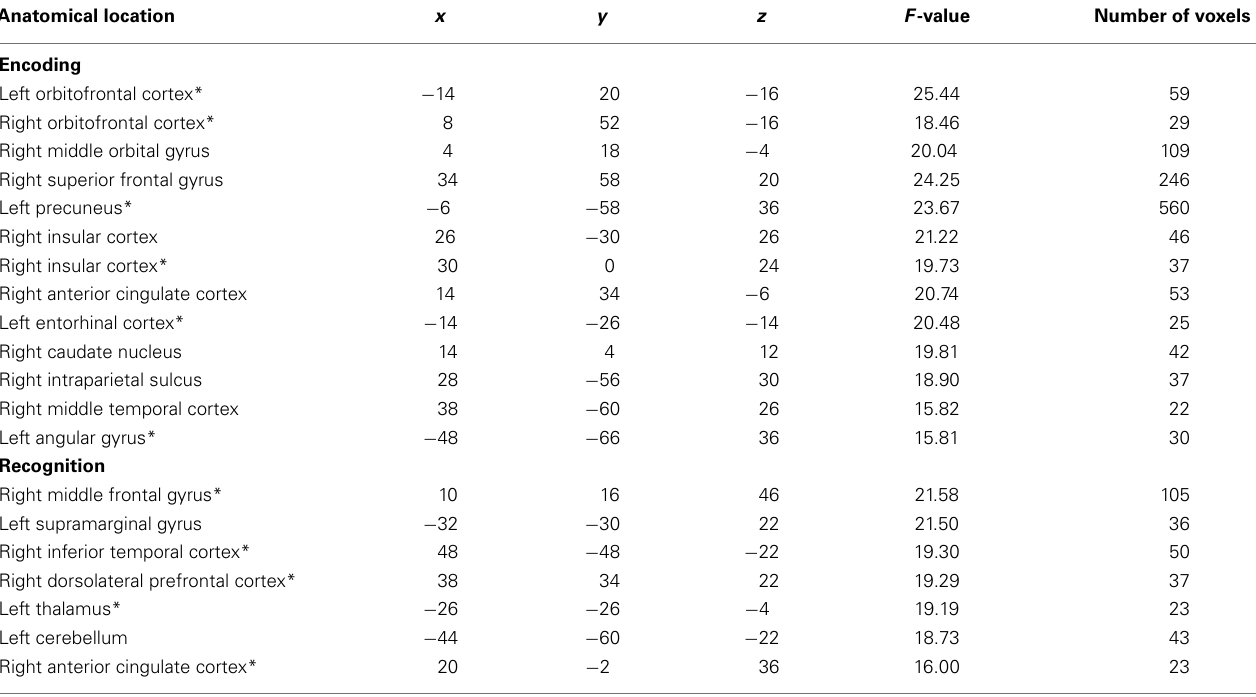
Table 4 |Activation peaks of the group × memory-success interaction effect. Anatomical